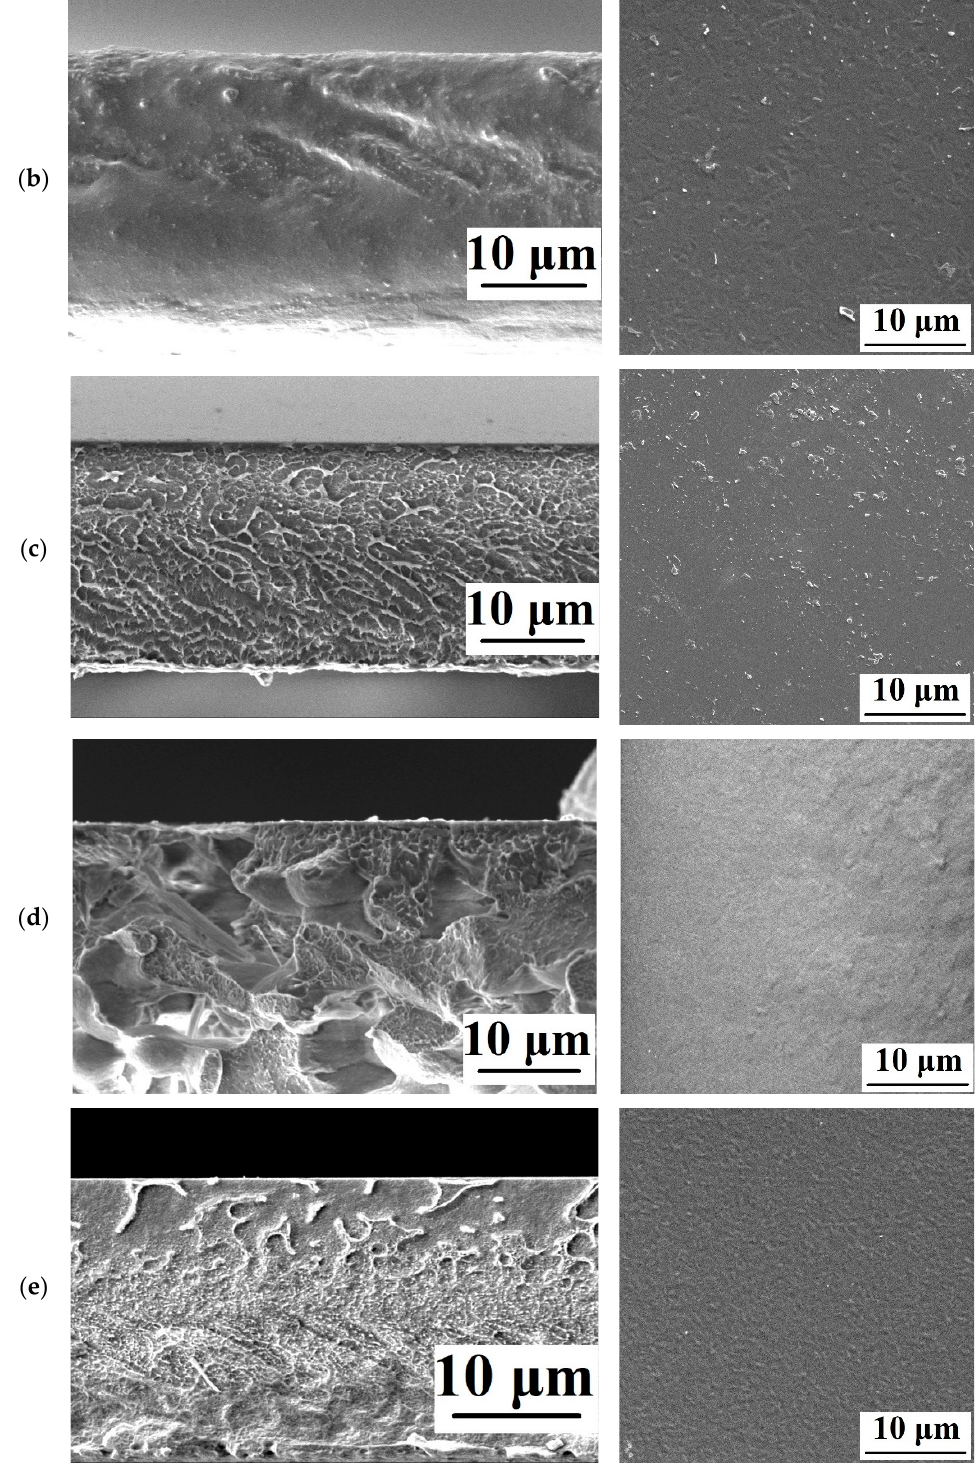
Figure 9. SEM micrographs of the cross section and surface of the developed dense membranes: ( a ) Figure PVDF dense , ( b ) PVDF+TiO 2 (0.5%) dense , ( c ) PVDF+GO-TiO 2 (0.5%) dense , ( d ) PVDF+MWCNT/TiO 2 (0.5%) dense , and ( e ) PVDF+Ag-TiO 2 (0.5%) dense . When nanoparticles were introduced into the PVDF matrix, significant changes oc-